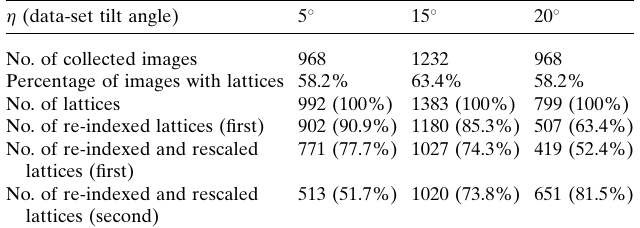
Table 1 Summarizing table. The results of data processing including success rates of indexing-ambiguity solution and scale-factor determination as explained in the text. (cid:2) (data-set tilt